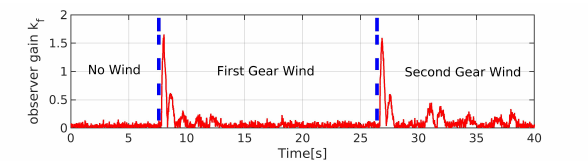
Figure 20. Disturbance estimation result from FASTESO.